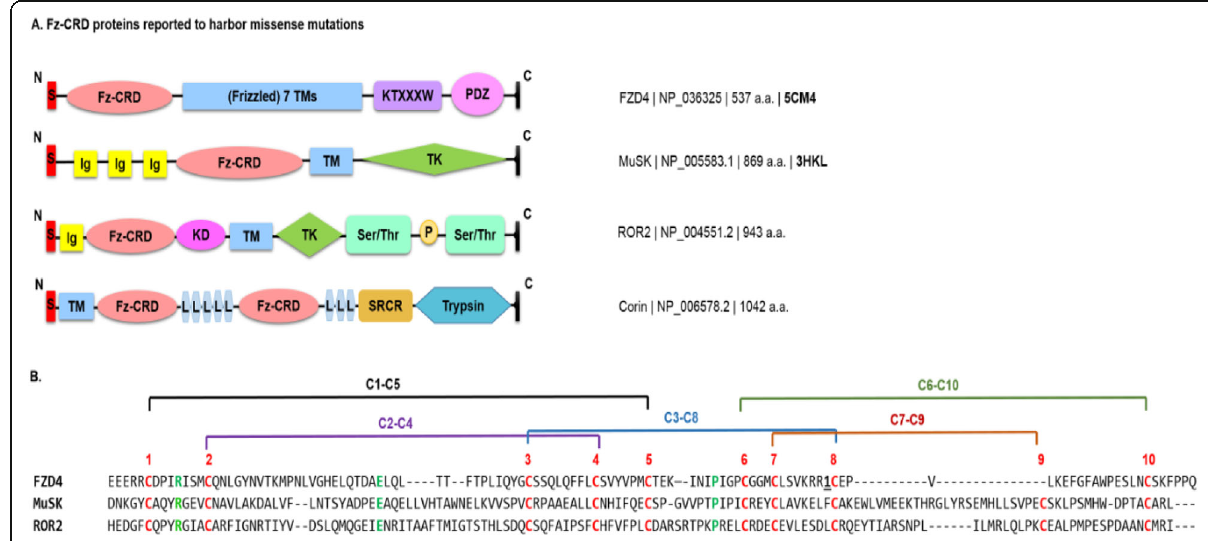
Fig. 1 Reported FZD4 proteins with disease-causing missense proteins. a Protein domain structural models for FZ-CRD proteins. HUGO gene symbols proteins are shown next to the protein structure and the NCBI accession number is shown next to each protein model. Available PDB codes are in bold at the far right. [PDZ: PDZ binding motif, KTXXXW: lysine-threonine-X-X-X-tryptophan, TM: transmembrane, FZ-CRD: frizzled cysteine- rich domain, TK: tyrosine kinase domain, Ig: immunoglobulin domain, Ser/Thr: Serine-threonine/tyrosine-protein kinase, KD: kinase domain, Trypsin: trypsin-like protease domain, SPCR: scavenger receptor cysteine-rich domain, and L: low density lipoprotein receptor repeats. b Multiple sequence alignment of FZD4, MuSK and ROR2 FZ-CRDs. Conserved cysteines are shown in red color. FZ-CRD show homology with a conserved pattern of “ CnCnCX8CX6CnCX3CX6,7CnCnC ” (Pei and Grishin 2012) C : conserved cysteine; n : a variable number of residues, Xn : n residues, and Xn1, n2 : n1 to n2 residues in α -helices forming a common Frizzled fold across four α -helices connected by disulfide bridges shown and labelled in red as: “ C1 – C5, C2 – C4, C3 – C8, C6 – C10, and C7 – C9 ” . For FZD4, one inserted region is shown as the number of inserted residues underlined in bold. Different residues exist between conserved C7 and C8. For FZDs the number is six and RTKs have seven